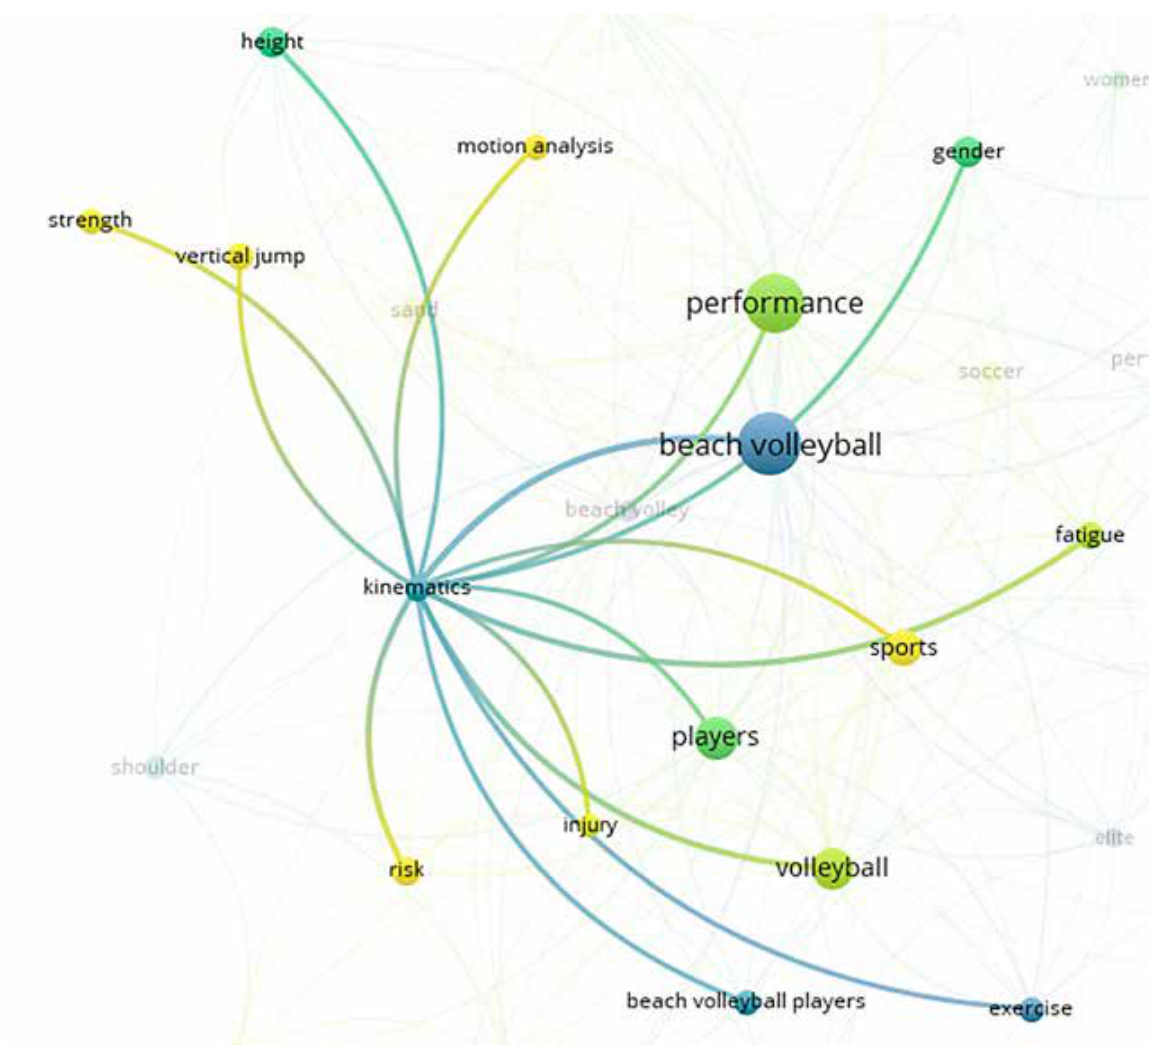
Figure 2. Keyword relationship “kinematics” (source: own research based on extracted data from WoS and analyzed with VOSviewer;